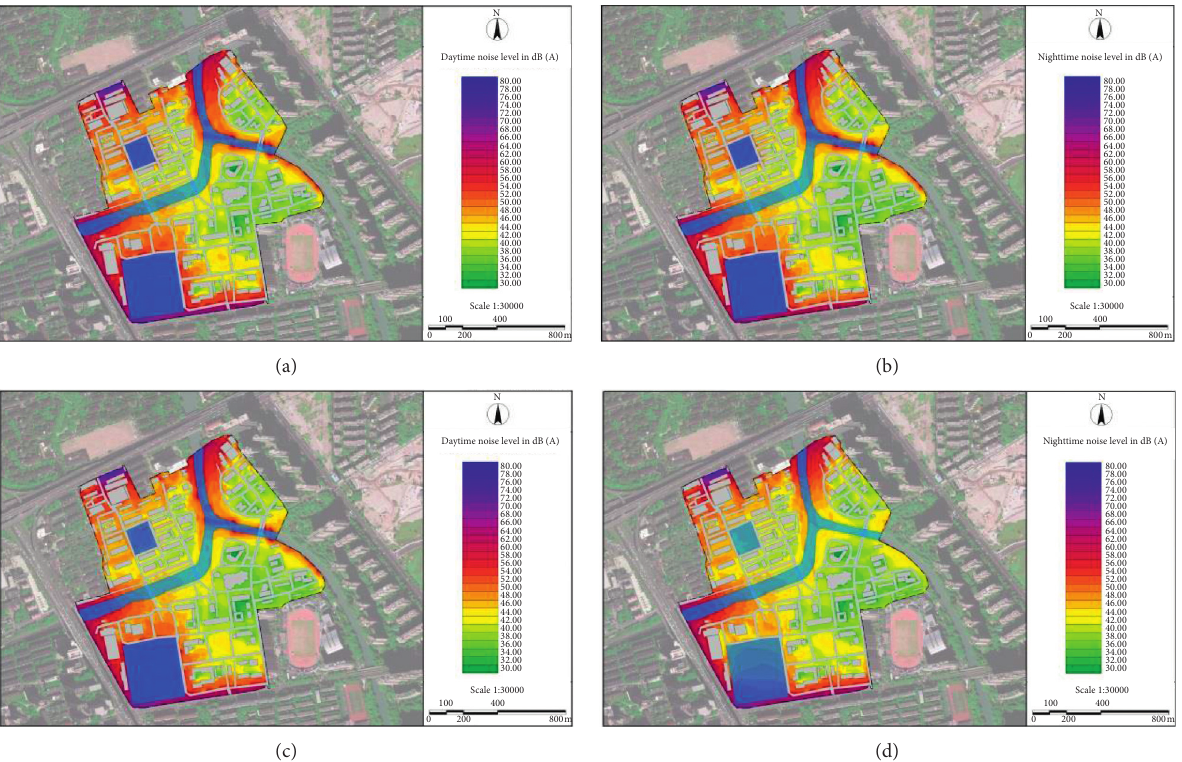
Figure 10: Simulation results of the campus of Zhejiang University of Technology with greenbelt optimisation: (a) weekdays daytime, (b) weekdays nighttime, (c) weekends daytime, and (d) weekends